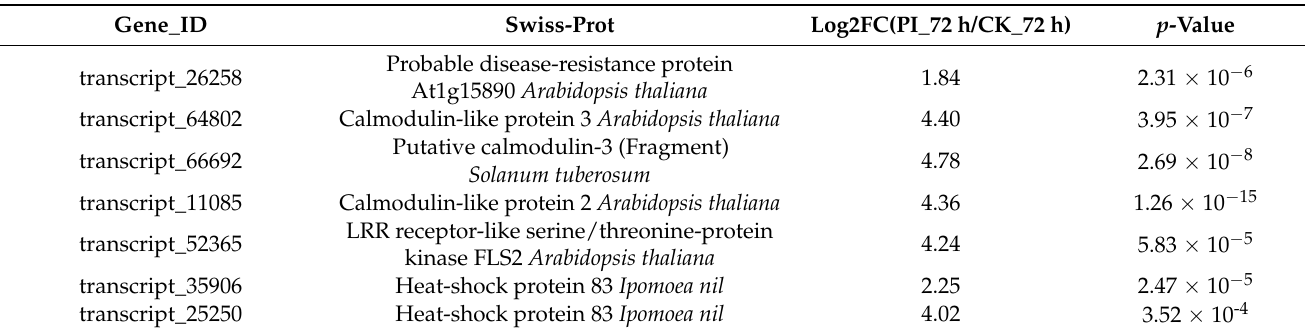
Table 3. The key DEGs involved in plant–pathogen interaction signaling pathway under the S. noctilio venom